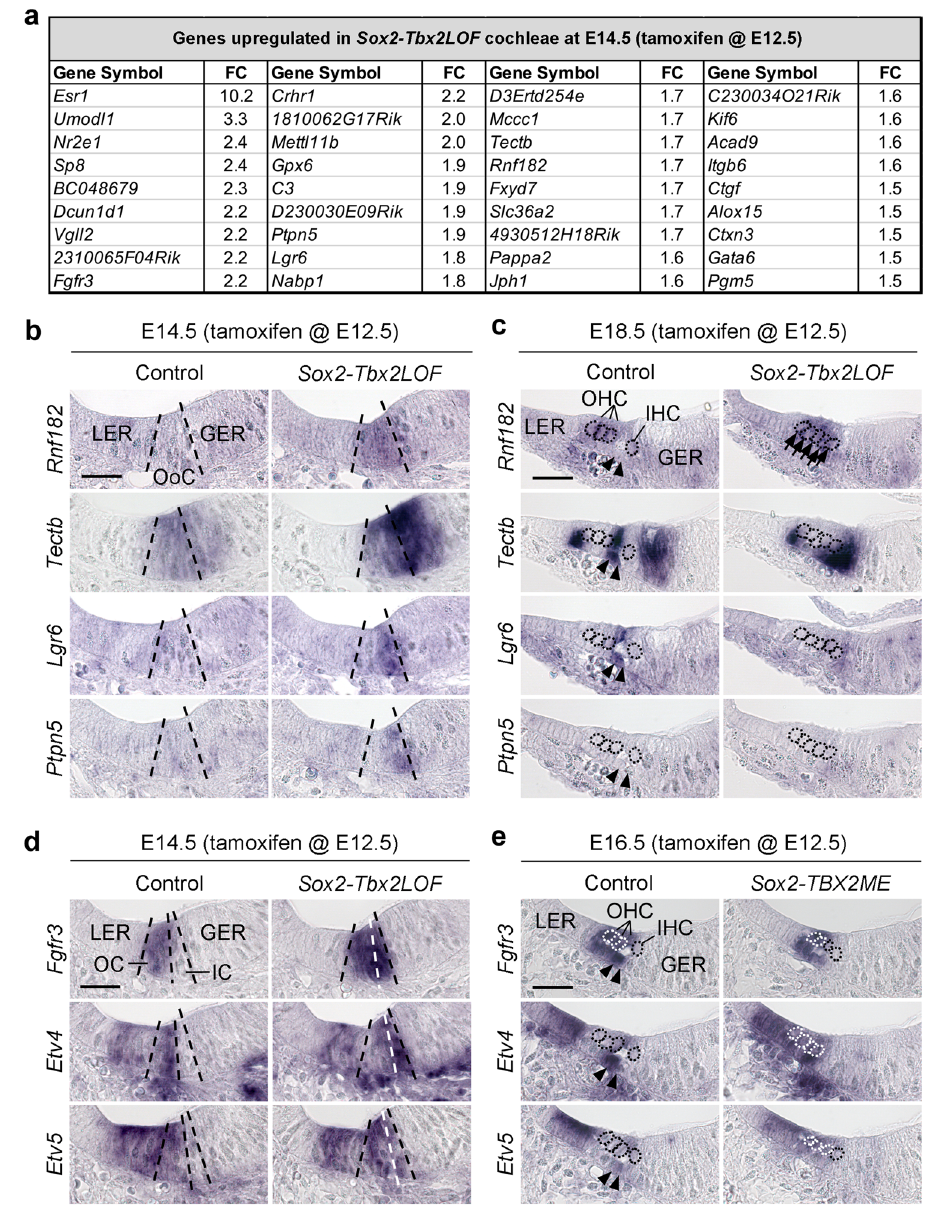
Fig.3| Tbx2 patternsprosensoryprogenitorsinthedevelopingorganofCorti. a – e Expression analysisof genes with increased expression in microarrays of E14.5 cochleae in which Tbx2 was ablated in prosensory cells ( Sox2-Tbx2LOF ) by tamox- ifenadministrationatE12.5. a Listofgeneswithincreased expressioninE14.5 Sox2- Tbx2LOF cochleae as detected by microarray analysis ( n =4). FC, fold change b – e RNAinsituhybridizationanalysisofselectedcandidates( b , c )onE14.5( b )and E18.5 ( c ) cochlear sections of Sox2-Tbx2LOF embryos, and of Fgfr3 and its target